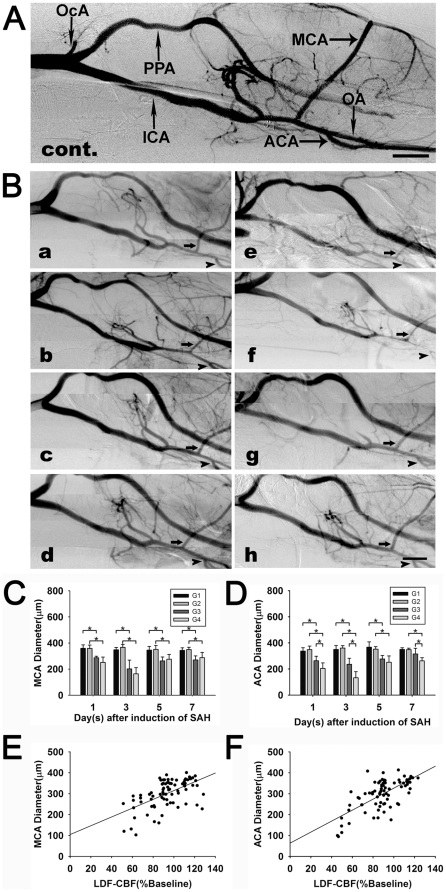
A representative SRA image of rat in control group (A).SRA imaging (B) at day 1 (a, e), 3 (b, f), 5 (c, g) and 7 (d, h) following SAH in cisterna magna blood injection (a, b, c, d) and prechiasmatic cistern blood injection group (e, f, g, h). Arrows indicate the vasospastic MCA; arrowheads indicate the vasospastic ACA. Scale bar = 2 mm. Bar graphs (C and D) show the MCA and ACA diameter in G1, G2, G3 and G4 groups at each time point after operation. Data are mean±SD. n = 5 in each group. *, p<0.05, G1 vs. G3, G2 vs. G4, G3 vs. G4. Correlation maps (E and F) display positive correlations between MCA (E), ACA (F) diameter (measured in SRA images) and the specific surface CBF in control and SAH groups. n = 5 in each group.